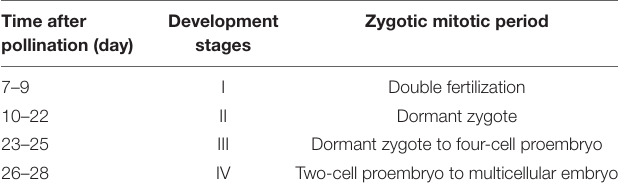
TABLE 1 | Zygote development after pollination.